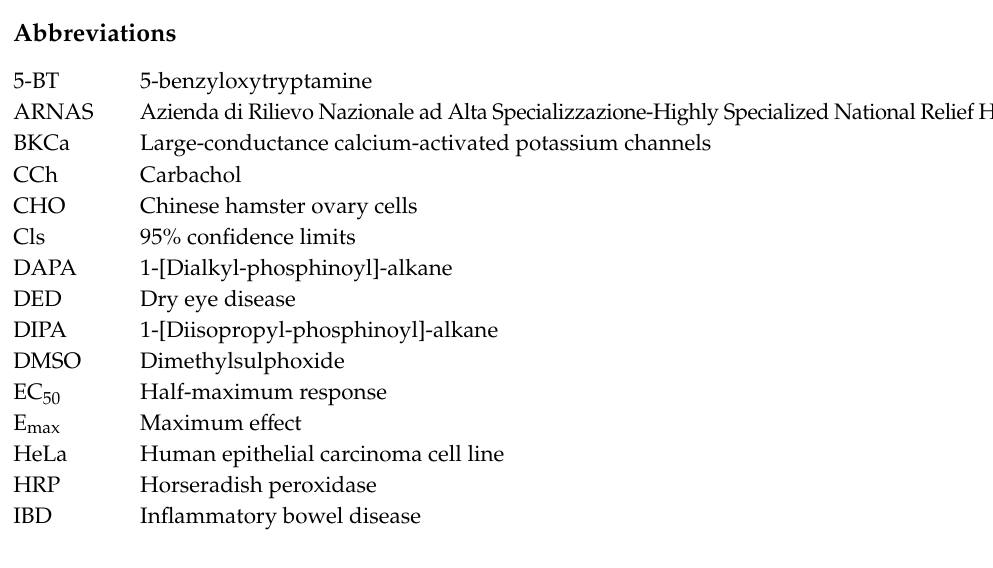
Table S1: Human colon spontaneous contraction frequency (cpm, contractions per minute) in control conditions or in the presence of the TRPM8 agonists; Figure S1: Typical tracings illustrating the response to DIPA 1–8 (1 µ M) in the circular muscle strip of human colon precontracted by carbachol (CCh) (0.1 µ M). W, washout. TRPM8 agonist induced a rapid